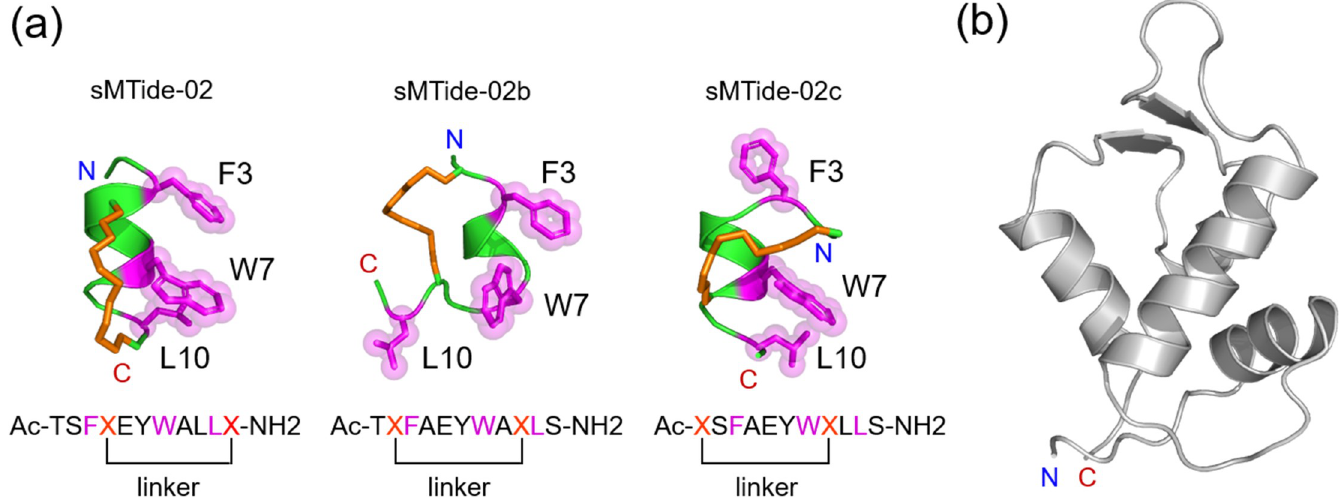
Fig 1. Stapled p53 peptide and HDM2 structures. (a) Simulated stapled p53 peptides (sMTide-02, sMTide-02b and sMTide-02c). Three epitope residues (F3, W7, and L10; colored magenta) and the hydrocarbon linker (colored orange) are indicated by stick representations. (b) X-ray structure for HDM2 (PDB ID 1YCR).